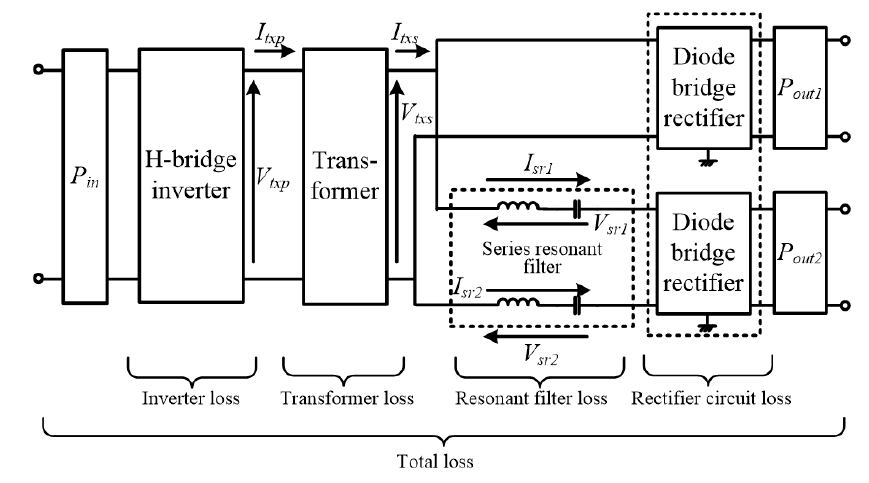
Figure 19. Points and loss positions of experimental test.